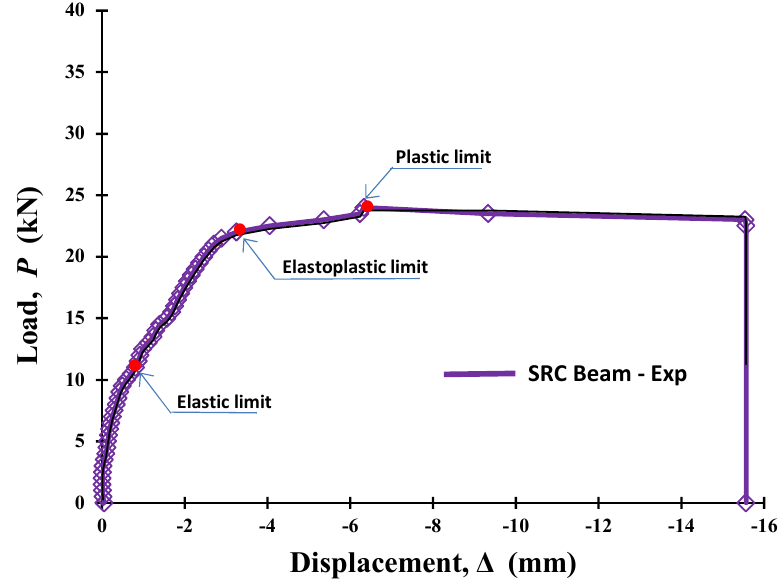
Figure 7. The relationship of load vs. displacement of SRC beam of experimental results.